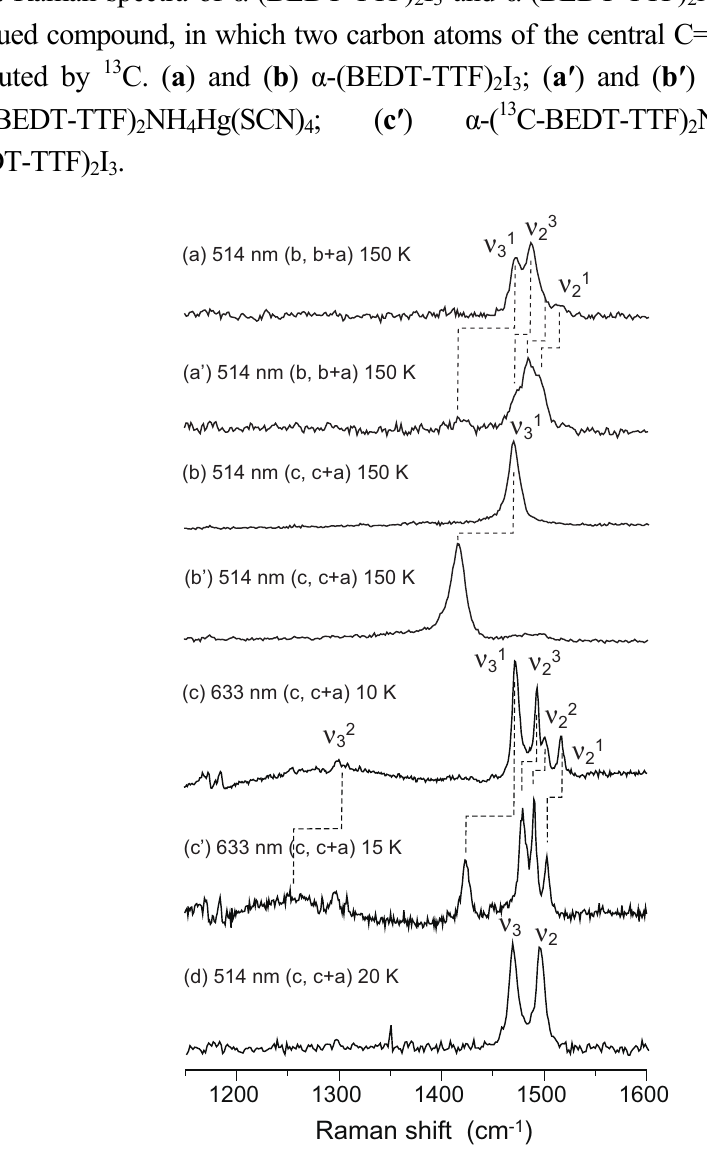
Table 2. Assignment of the Raman modes of α -(BEDT-TTF)